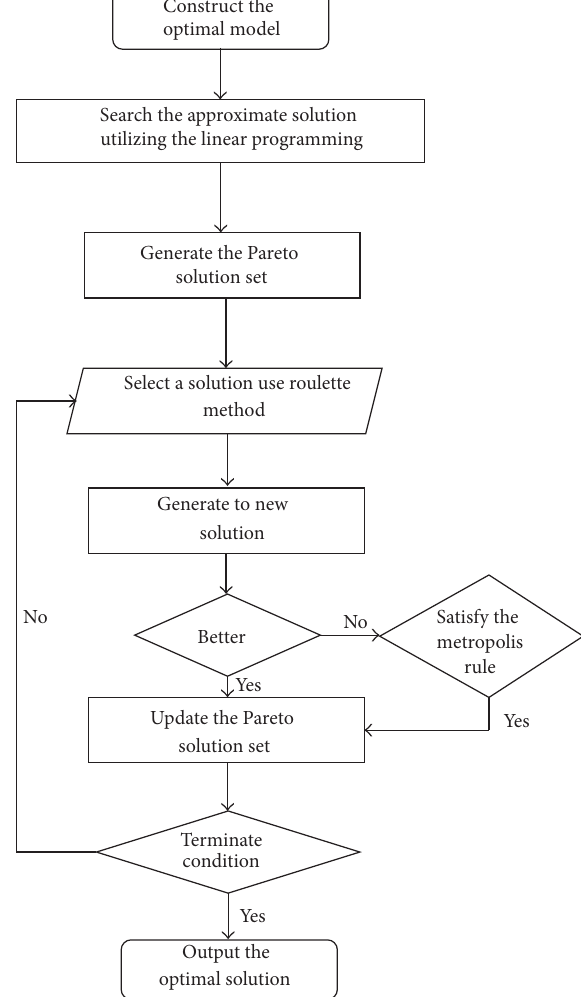
Figure 1: Flowchart of our